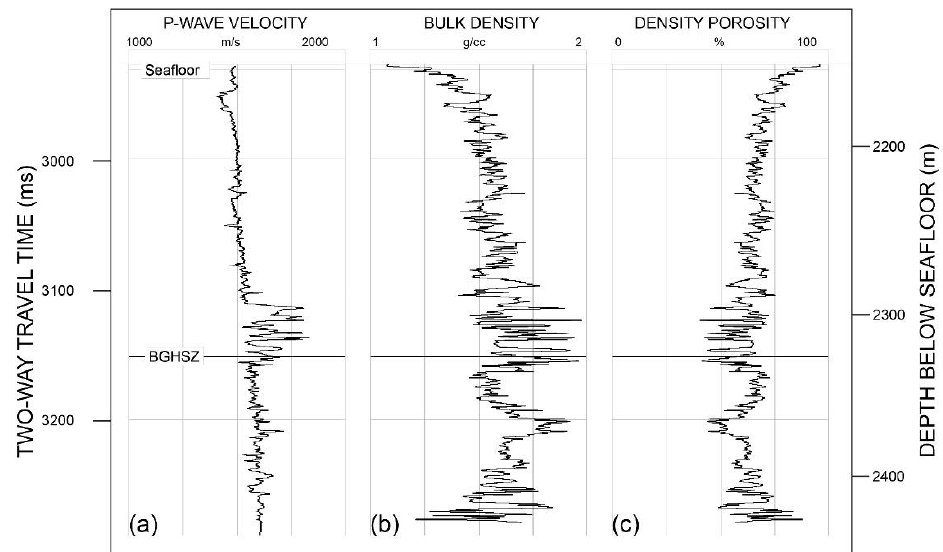
Figure 3. ( a ) P-wave velocity, ( b ) bulk density, and ( c ) density porosity in the UBGH2-6 well. Den- sity porosity was computed from bulk density with the average matrix density (2.64 g/cm 3 ) and fluid density (1.02 g/cm 3 ).